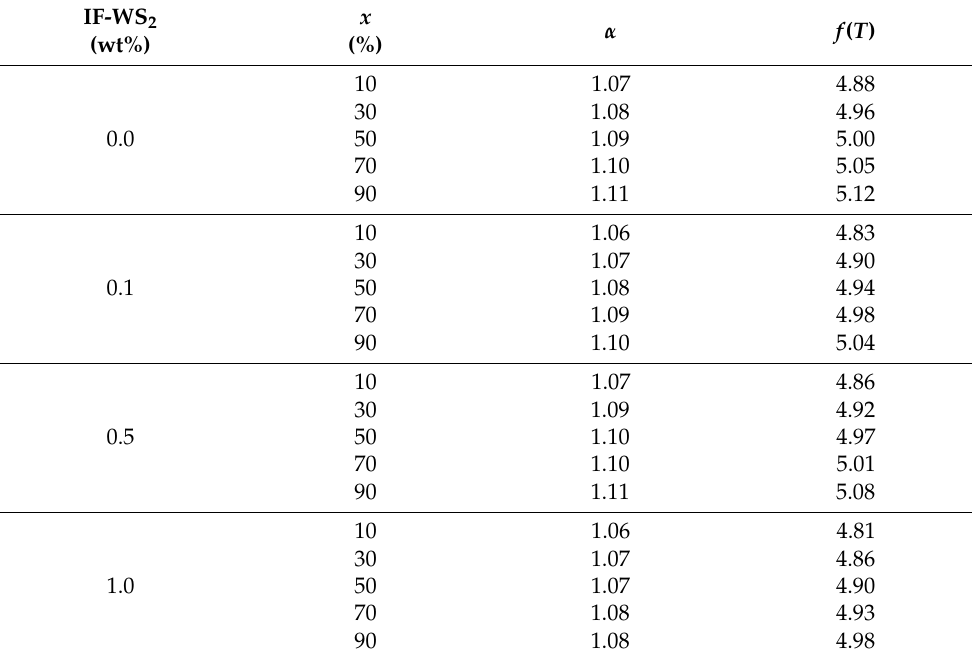
Table 2. Values of α and f ( T ) vs. conversion (x) based on the Liu model for pure PLLA and PLLA/IF- WS 2